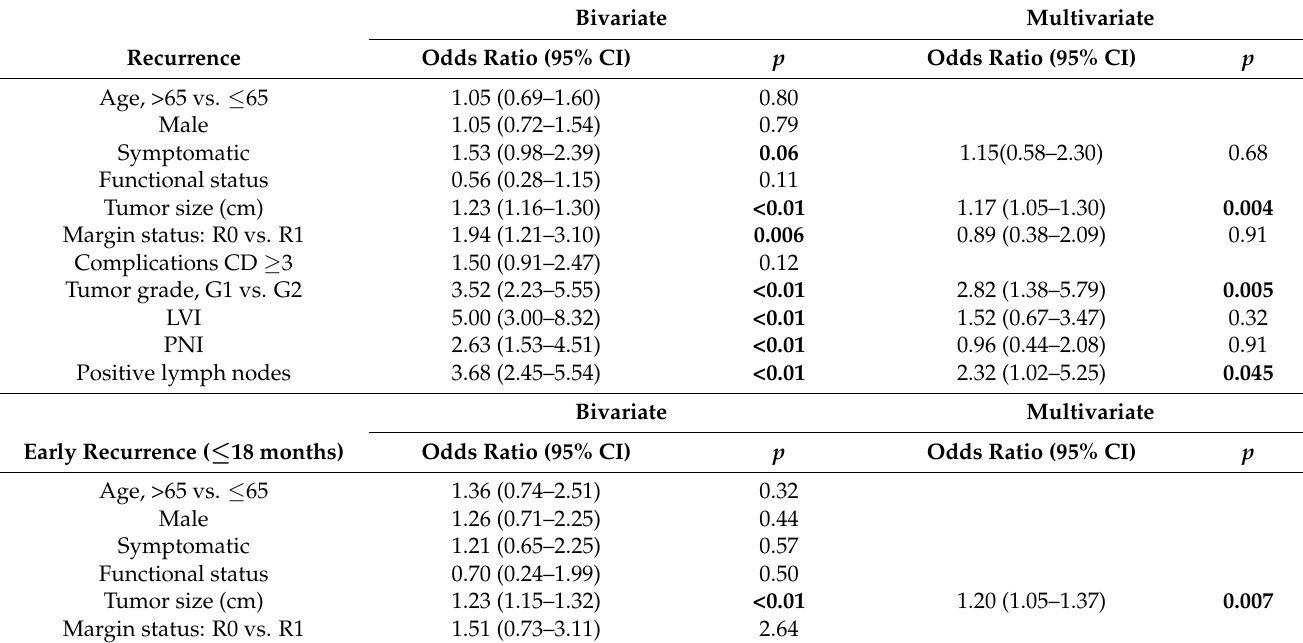
Figure 3. The receiver-operating curve of the risk factors lymph node invasion and tumor size on ER in patients with a pNET. Table 3. Risk factors for recurrence in patients with a pNET.